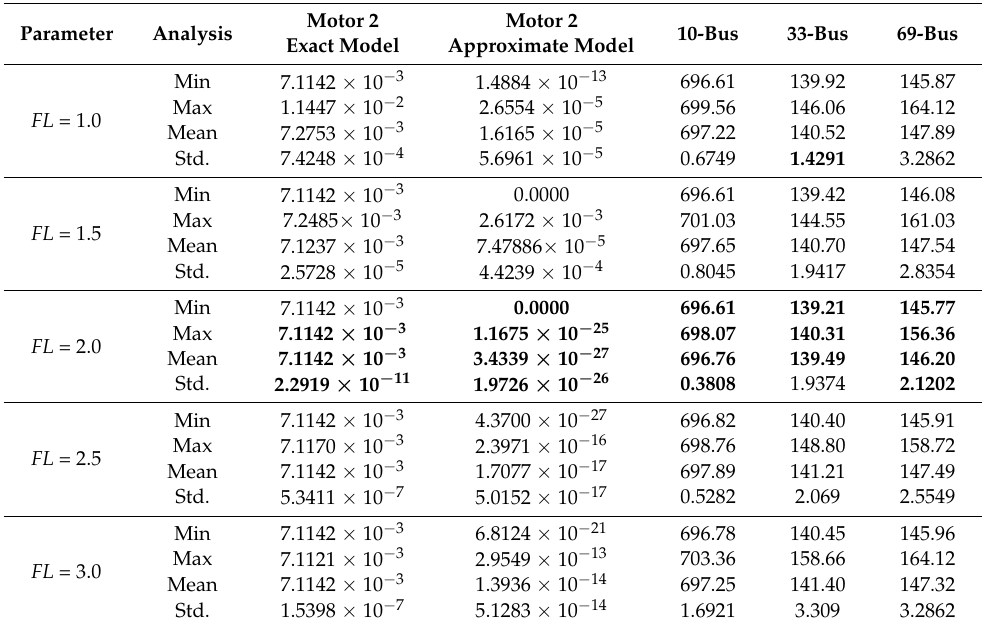
Table 3. Sensitivity Analysis of FL parameter.